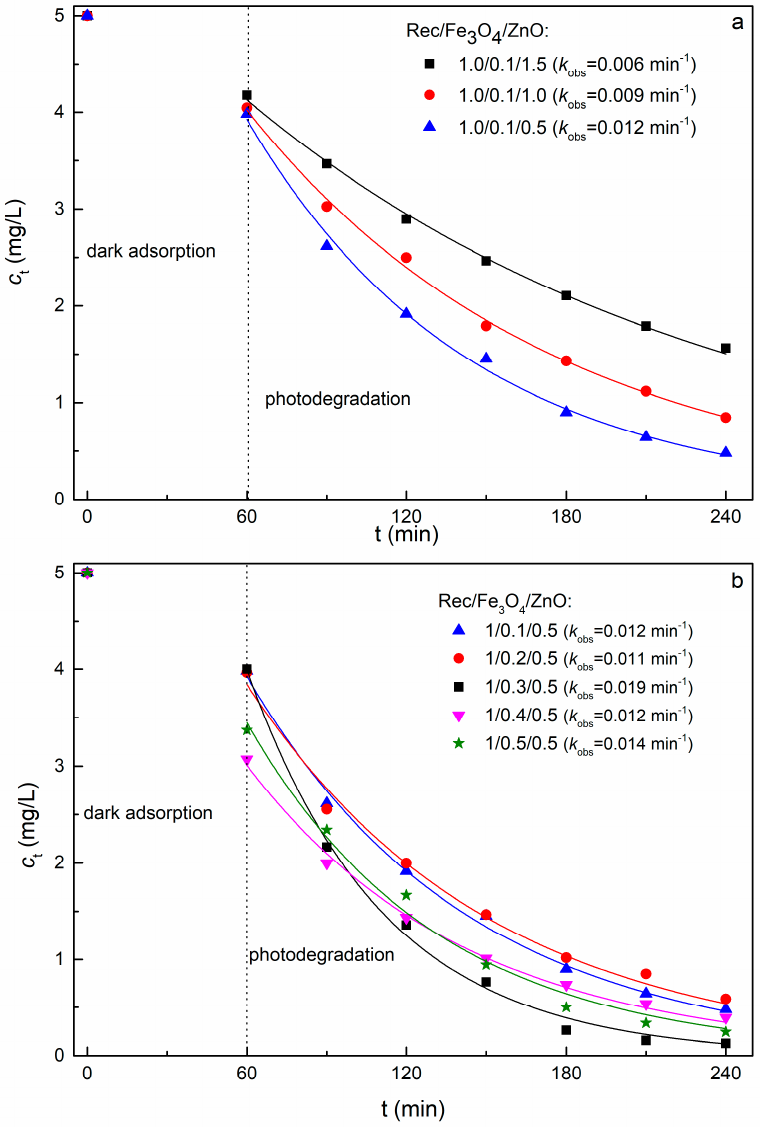
Figure 6. Effects of ( a ) ZnO and ( b ) Fe 3 O 4 mass contents of REC/Fe 3 O 4 /ZnO on the adsorption and photodegradation of MB dye.